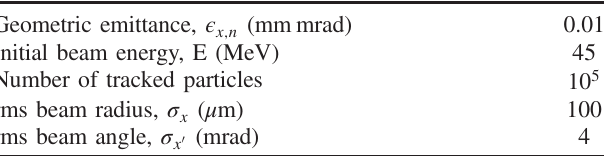
TABLE IV. The characteristics of the electron beam used in tracking